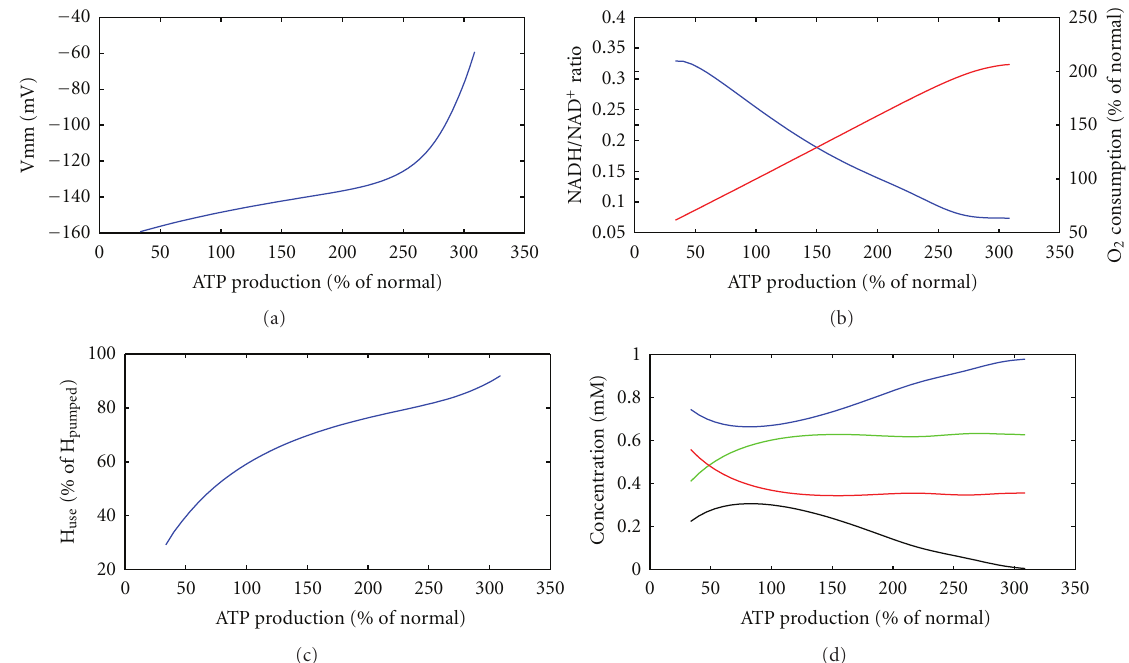
Figure 4: System characteristics under energetic challenge. Energetic demand was varied and behaviour of system variables determined. (a) mitochondrial membrane potential; (b) blue NADH to NAD ratio, red oxygen consumption rate; (c) share of created proton gradient used for ATP synthesis; (d) blue: ubiquinon at p-site, green: ubiquinol at n-site, red: ubiquinon at n-site, black: ubiquinol at p-site. ATP production and oxygen consumption are normalized to the reference state of the